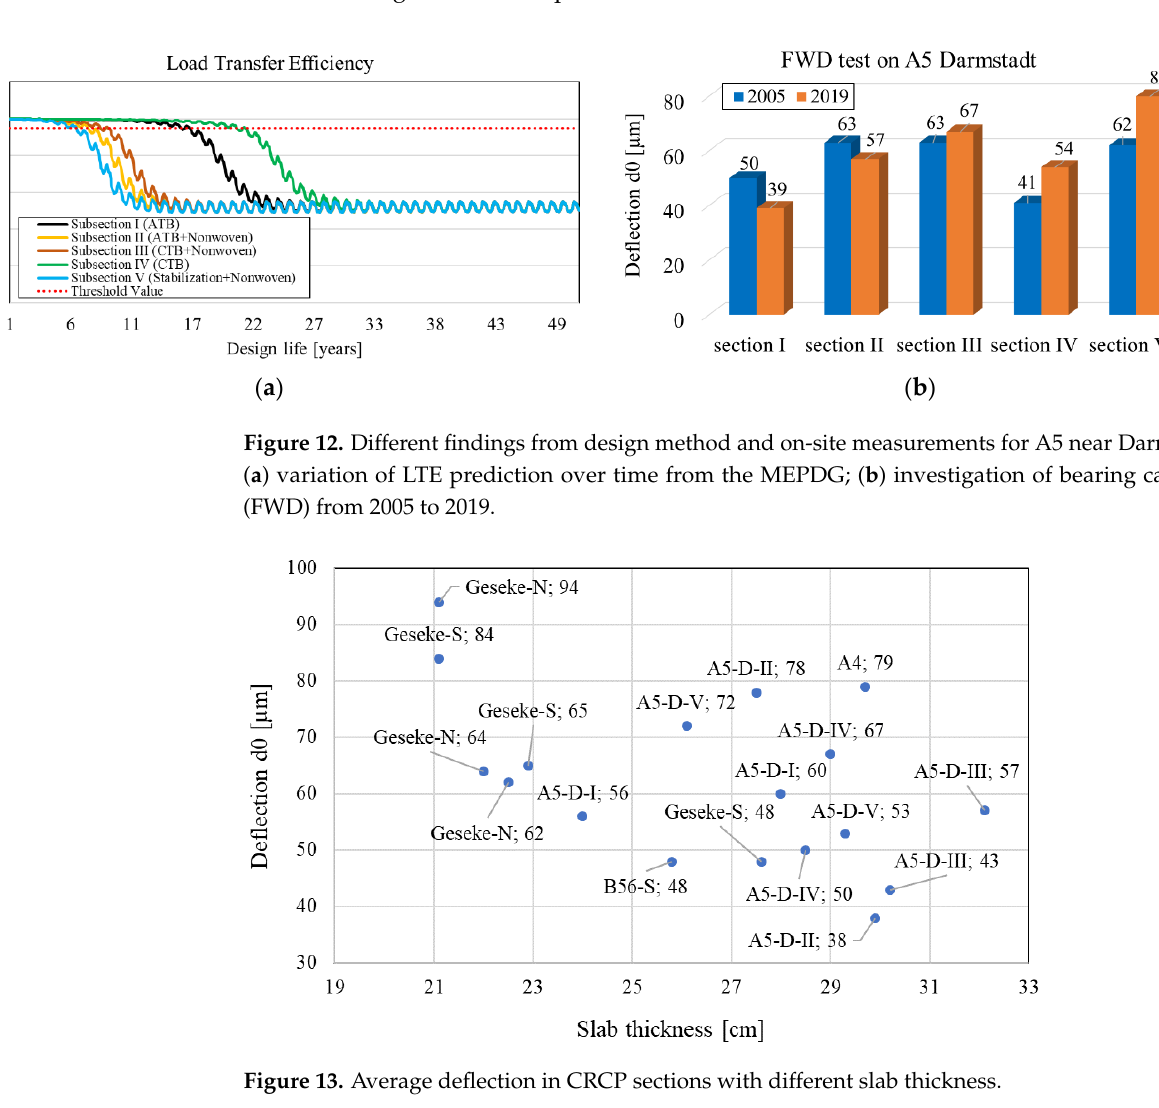
Figure 11. Different findings from design method and on-site measurements for Geseke private road: ( a ) variation of LTE prediction over time from the MEPDG; ( b ) investigation of bearing capac- ity (FWD) from 2009 to 2019.